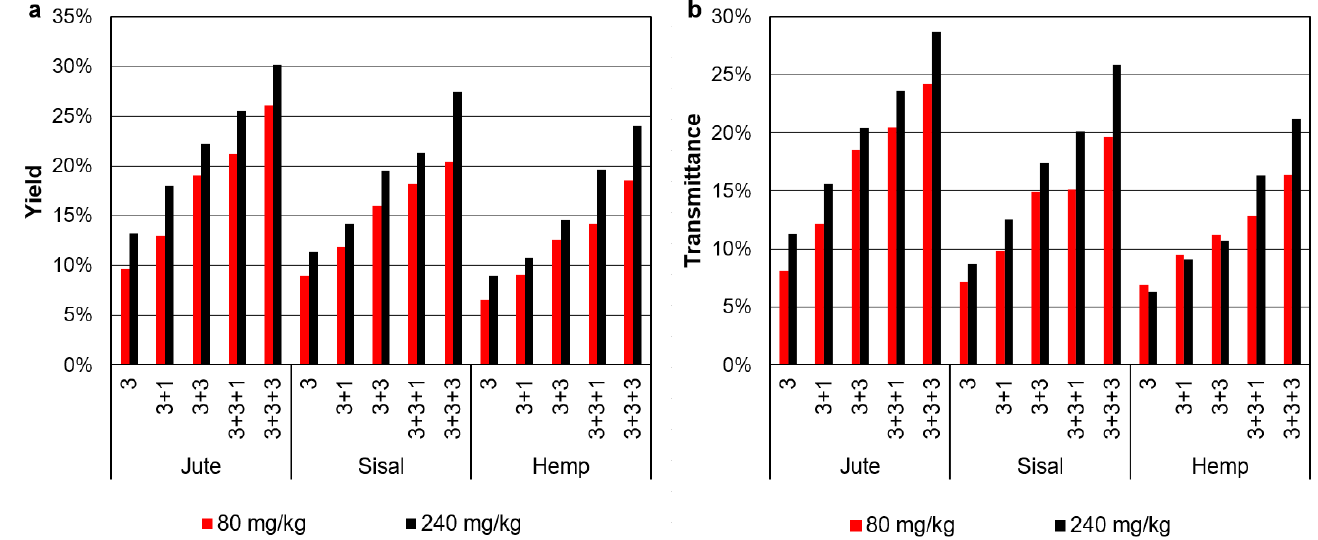
Figure 5. Yield of nanofibrillation ( a ) and transmittance at 600 nm ( b ) for jute, sisal and hemp MNCF whose pretreatment consistent of an endoglucanase-mediated hydrolysis at different dosages. The horizontal axis indicates the HPH sequence: cycles at 300 bar, at 600 bar and at 900 bar.